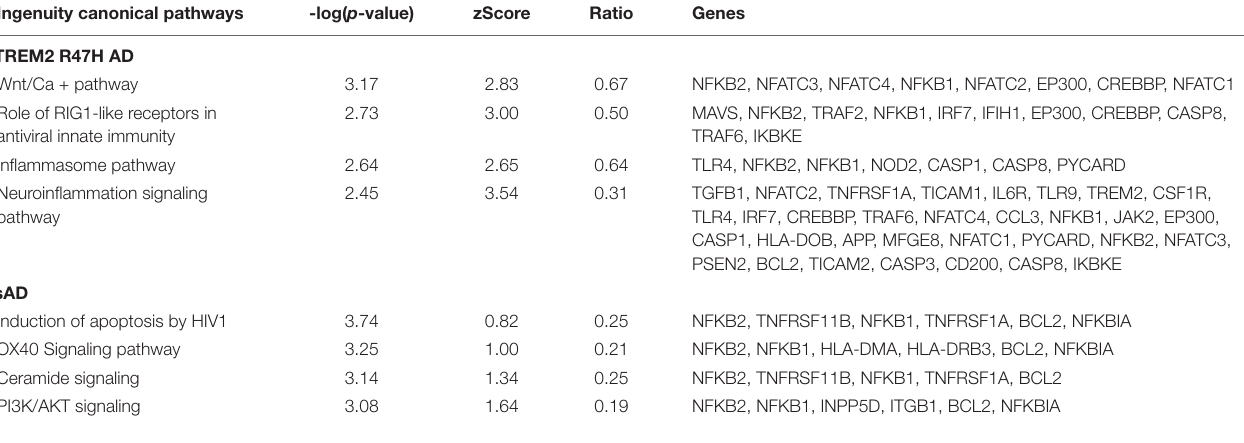
TABLE 1 | Top canonical pathways from Ingenuity pathway analysis of DE genes in TREM2 R47H AD and sAD. Ingenuity canonical